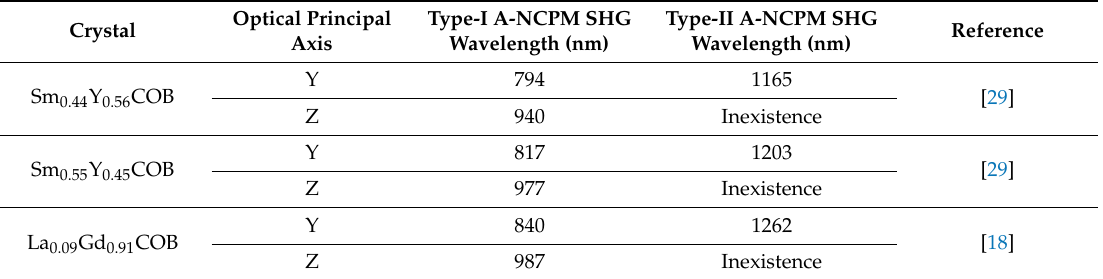
Table 2. The A-NCPM SHG wavelengths of mixed RE1 x RE2 1 − x COB crystals.